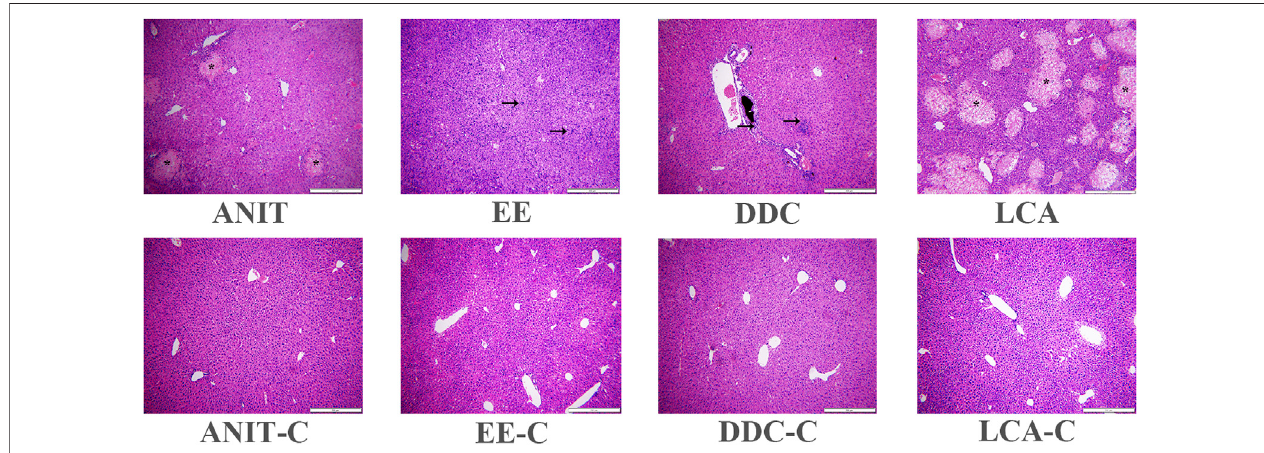
FIGURE 2 | Representative H&E stained liver sections (10 × 10). Characteristic bile infarcts as shown by the asterisk, in fl ammatory in fi ltration, destructive interlobular ducts as shown by the